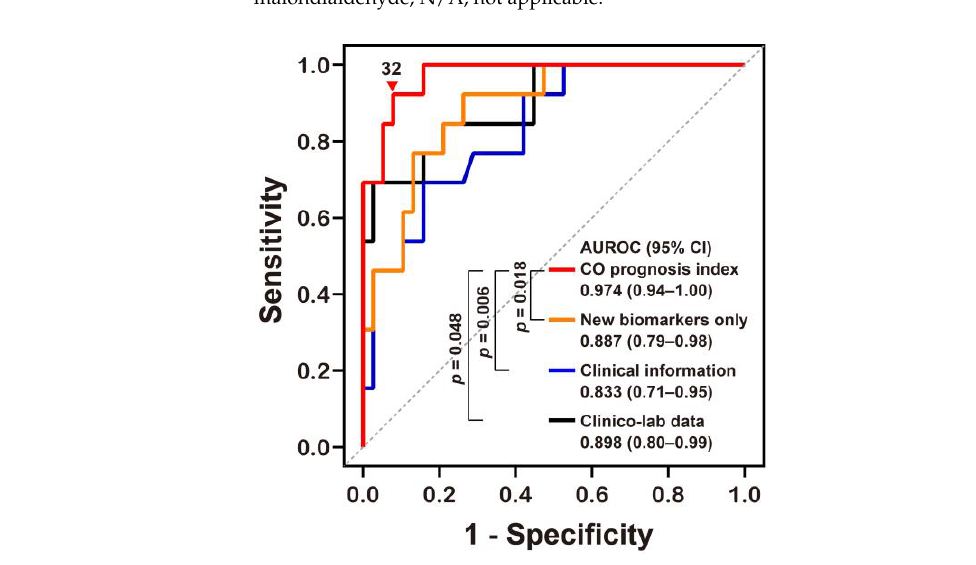
Figure 3. Receiver operating characteristic curve analyses of the novel prognostic index for predict- ing neurocognitive outcomes following CO poisoning. The equation for predicting CO